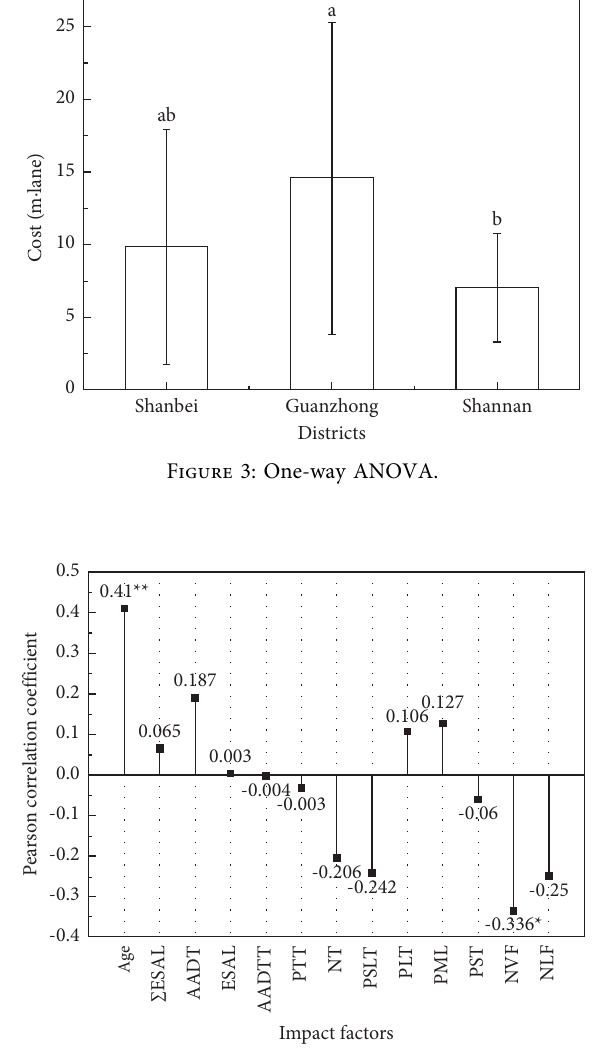
Figure 4: Correlation coefcients between dependent and inde- pendent